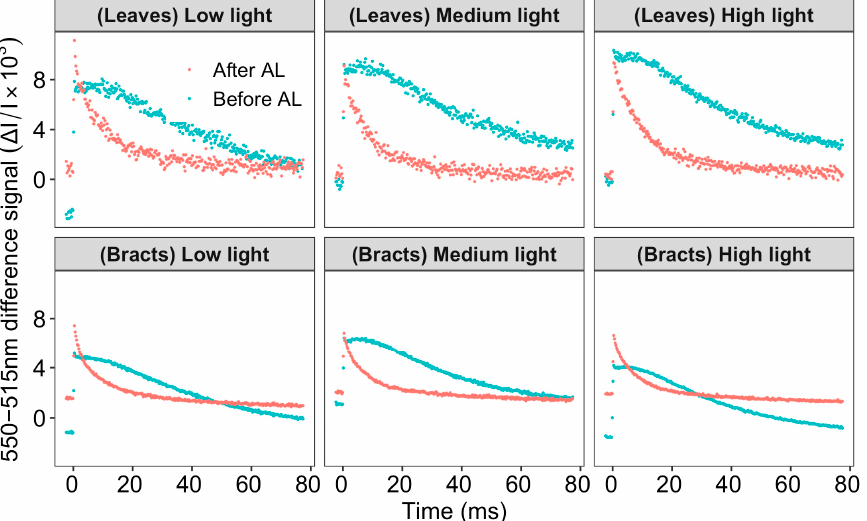
Figure 4. Changes in the P515 signal when a single-turnover saturating flash was applied to cotton leaves and bracts ( n = 3) that had been given pre-illumination at different light intensities of 400 μ mol m − 2 s − 1 (low light), 1800 μ mol m − 2 s − 1 (medium light), or 2800 μ mol m − 2 s − 1 (high light). After AL: the actinic light was turned on for 10 min, and then turned off, followed by dark adaptation for 4 min before measurement. Before AL: measurement of leaves and bracts after 1 h dark adaptation.